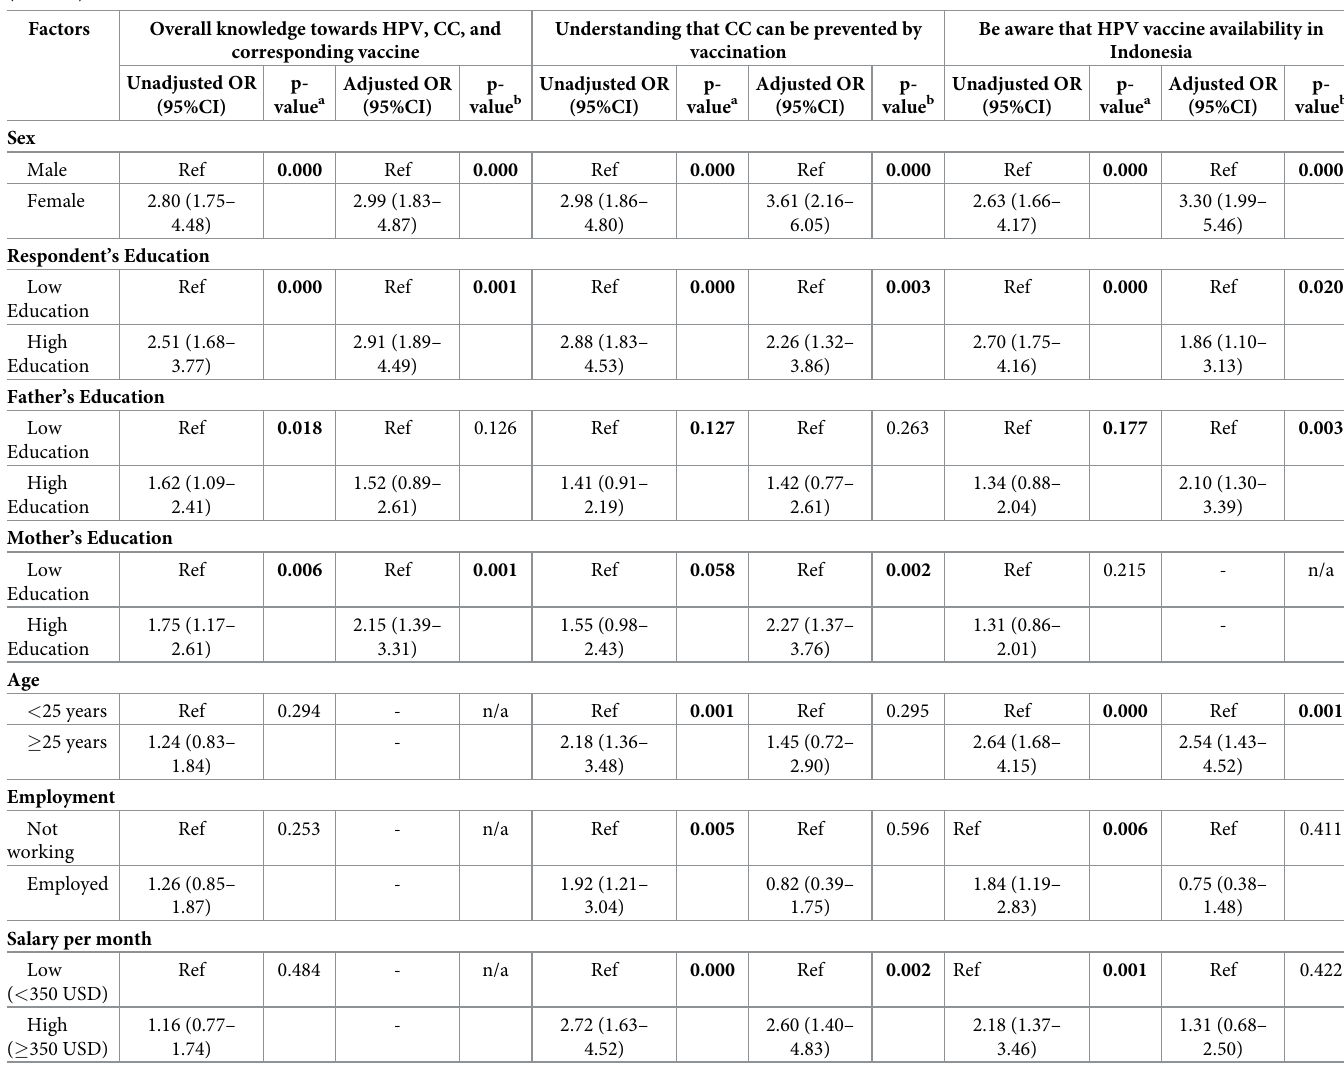
Table 3. Multivariate logistic regression analysis for factors towards good knowledge and other related aspects of knowledge regarding HPV, CC, and the vaccine (N = 400).